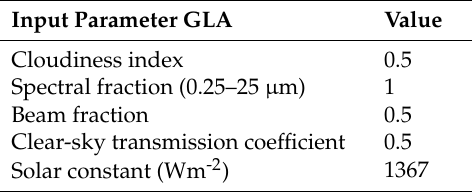
Table 2. Input parameters of GLA. This setting was retained for both fisheye and orthographic image